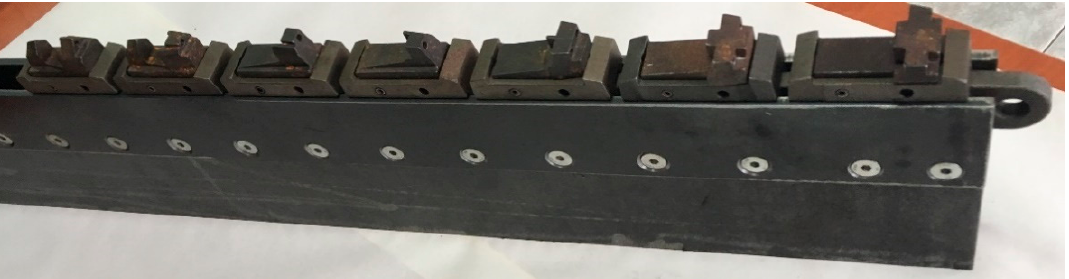
Figure 8. A rock chainsaw sequence in the driving slot.